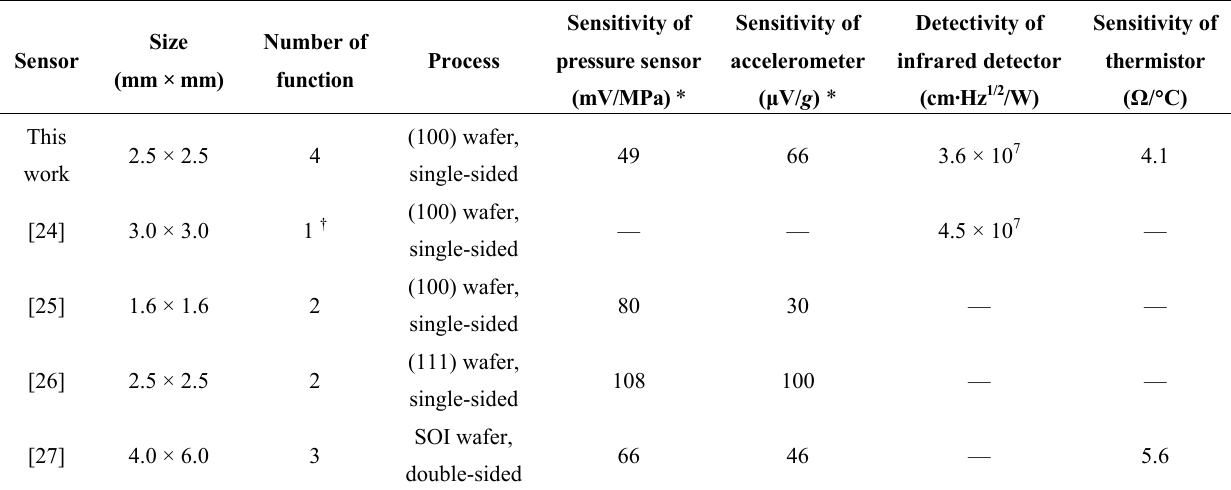
Table 4. Comparison of PATIR sensor with reported single-chip integrated composite